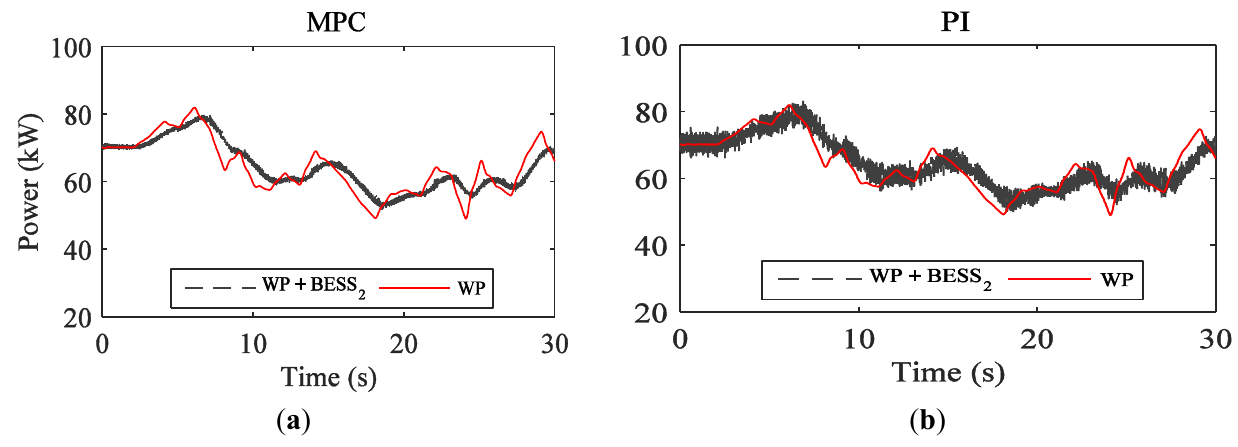
Figure 6. Smoothened wind power: ( a ) MPC technique; ( b ) PI